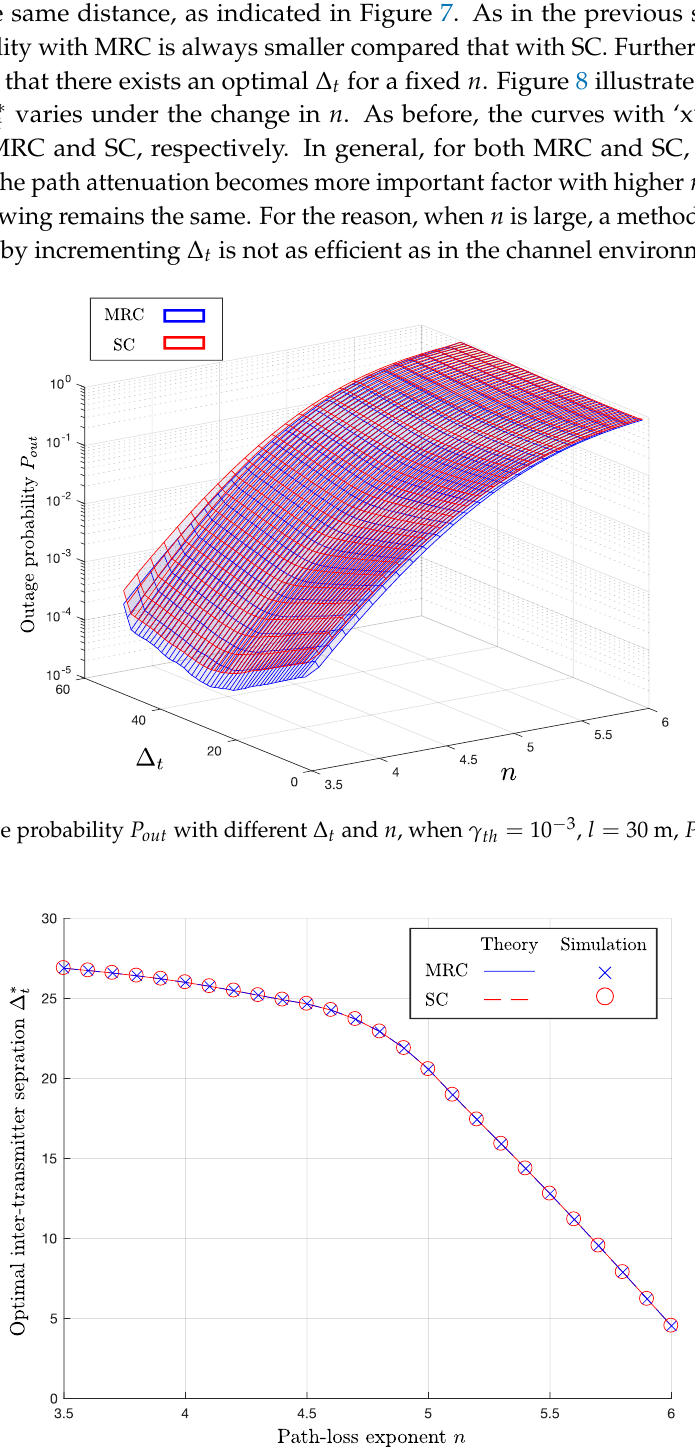
Figure 8. Optimal Inter-transmitter separation ∆ ∗ l = 30 m, P T = 50 dB, and σ = 8